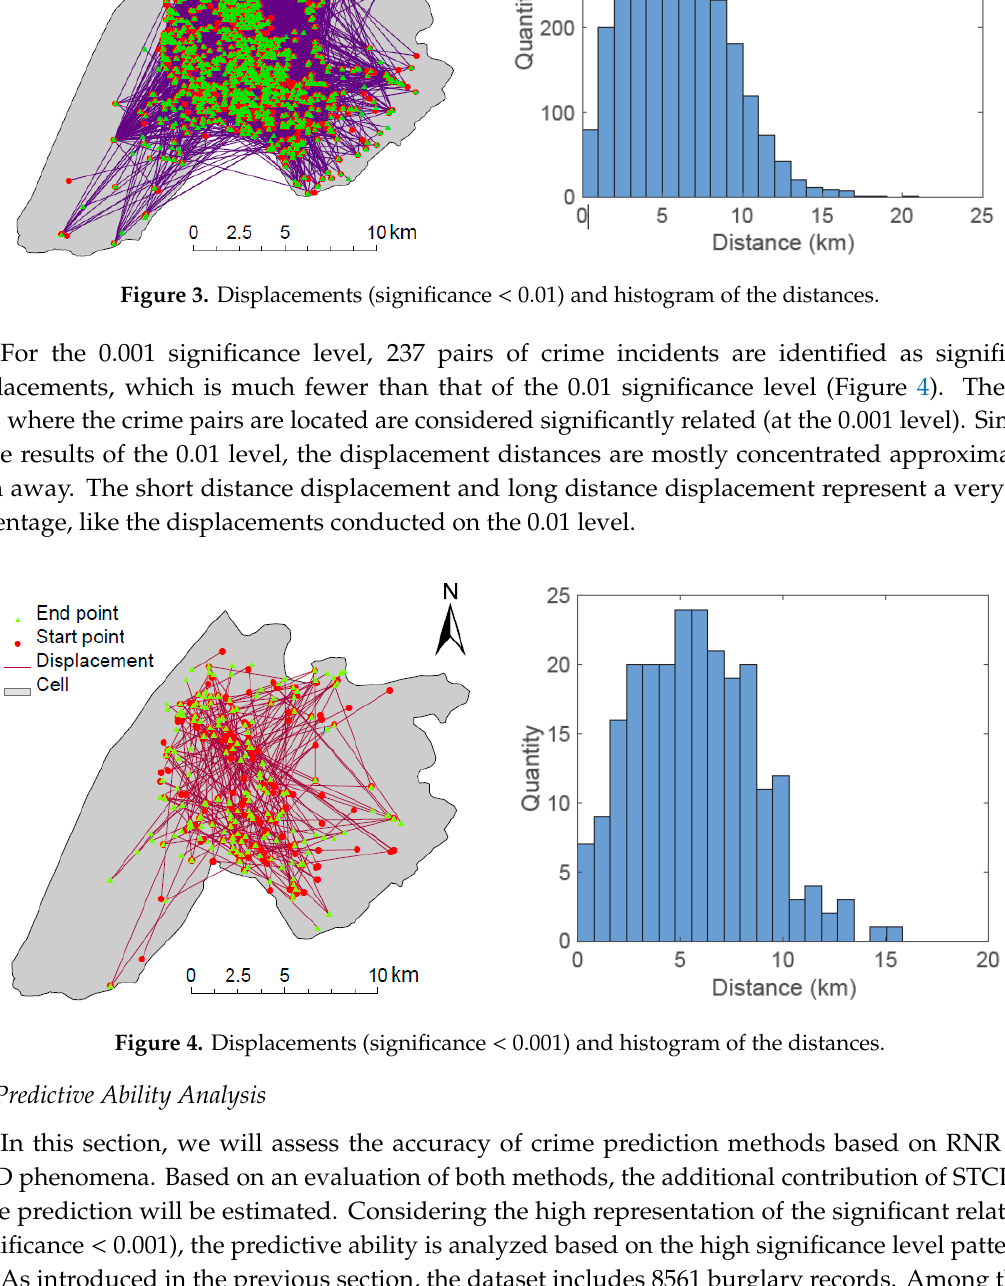
Table 2. Accuracy of crime prediction based on RNR and STCD.